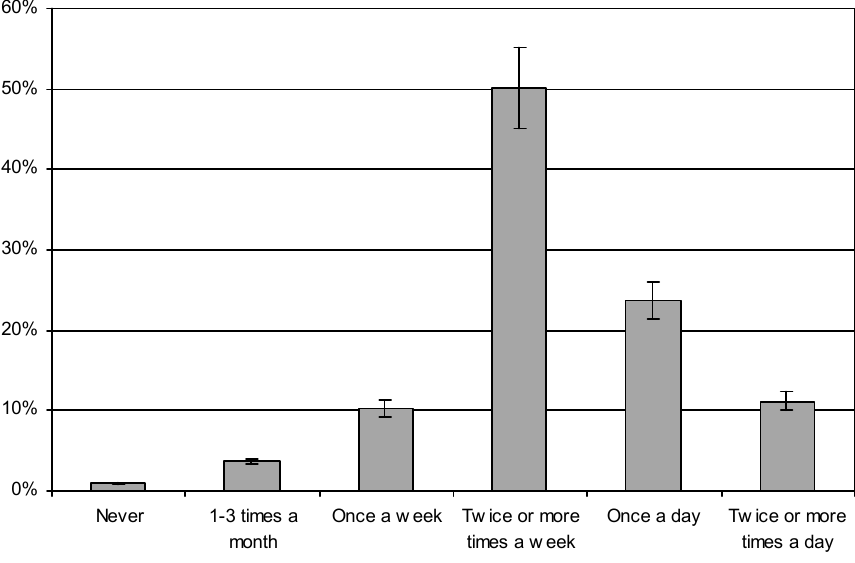
Figure 4. The consumption of white and wholemeal bread and other cereal products.